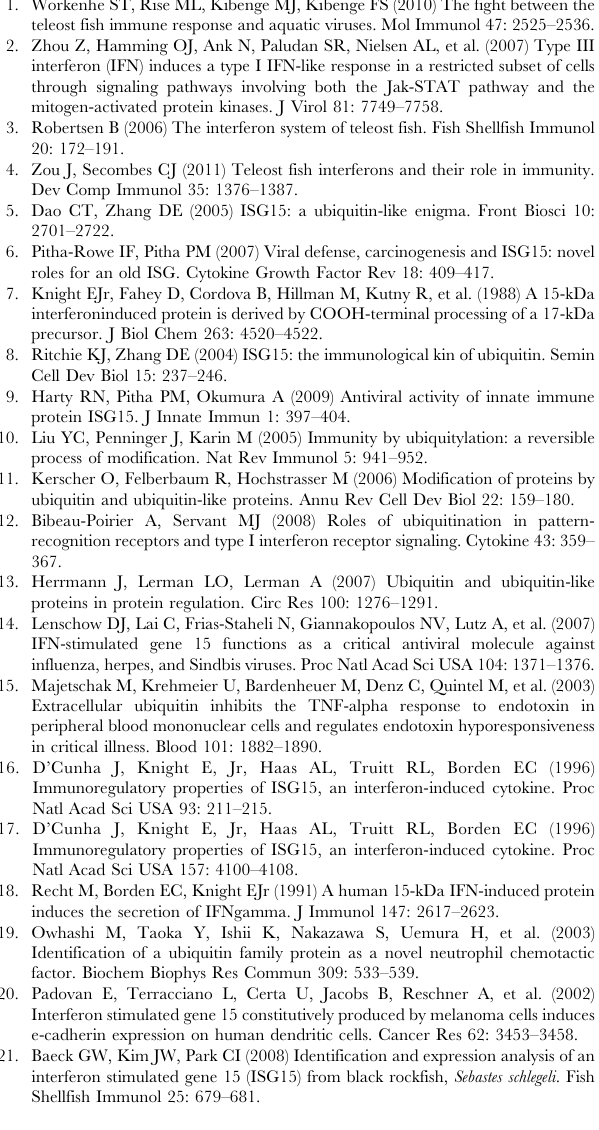
60150), Danio rerio (NP_001191098), Homo sapiens (AAH09507), Mus musculus (AAH31424). (TIF) Figure S4 CsISG15 production in lymphocytes subject- ed to RNAi. Tongue sole head kidney lymphocytes transfected with pRNAT-CMV3.1 (control), pRiNC1, and pRiCsISG15 (lanes 2, 3, and 4 respectively) were infected with megalocytivirus for 4 h. Extracellular (A and B) and cytoplasmic (C and D) proteins were prepared and subjected to immunoblot with antibodies against rCsISG15 (A and C) or b -actin (B and D). Lane 1, protein marker.